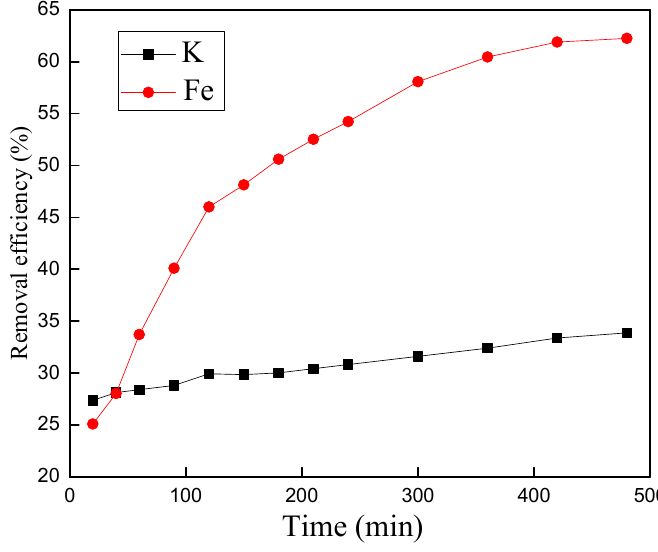
Figure 10. Effect of reaction time on the removal efficiency.